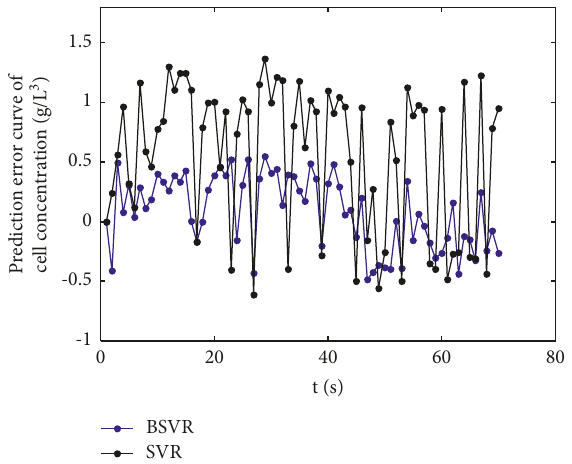
Figure 5: Comparison of ethanol concentrations based on SVR and offline assay values.